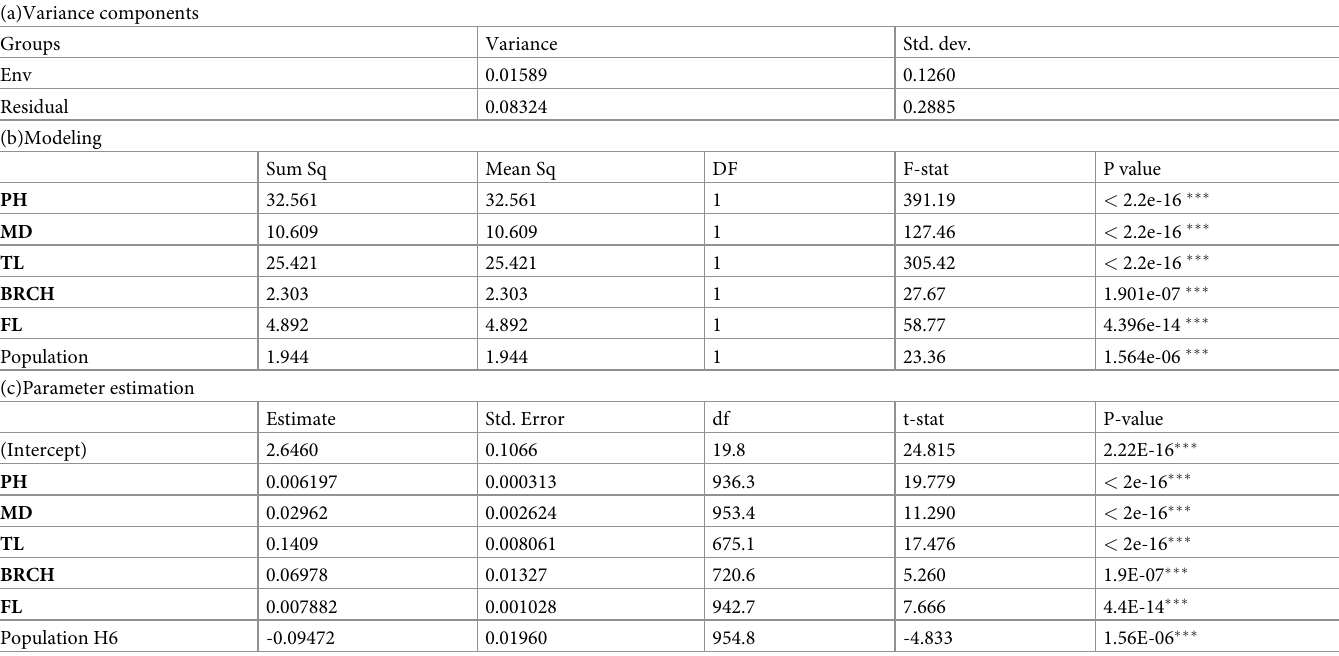
Table 5. A mixed-effect model and parameter estimations for predicting Biomass (natural log transformation) in the SBSH-BC 1 F 2